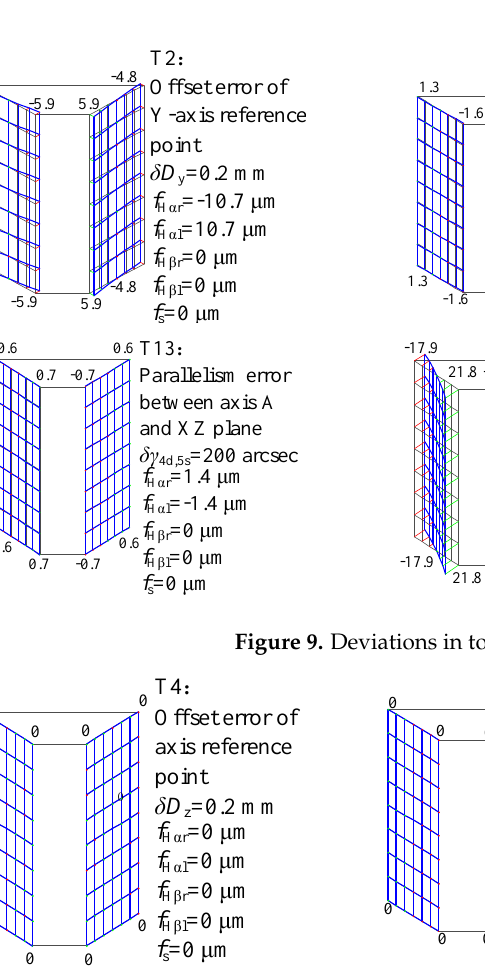
Figure 8. Deviations in tooth surface produced by assembly errors T1, T3, T6, and T8.